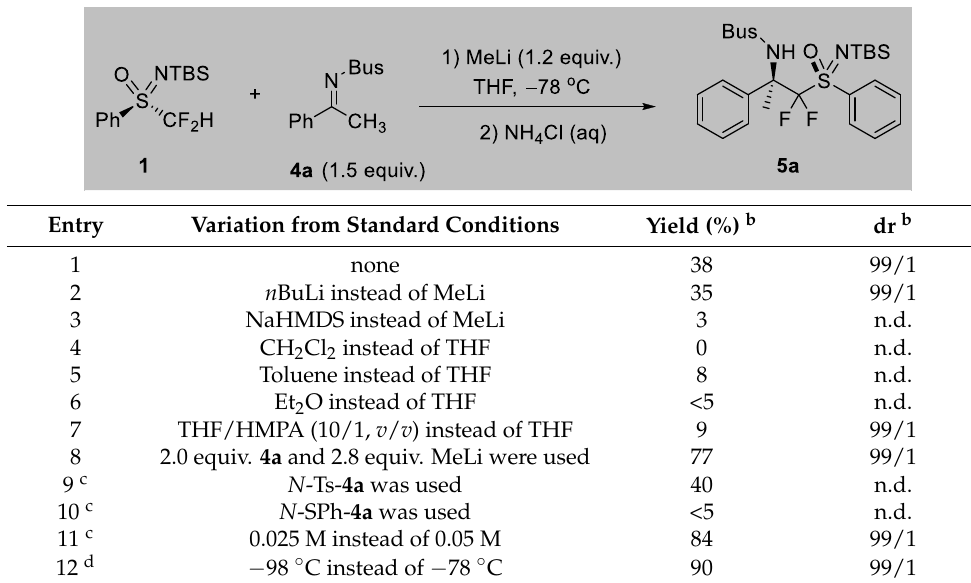
Table 1. The optimization of reaction conditions a .